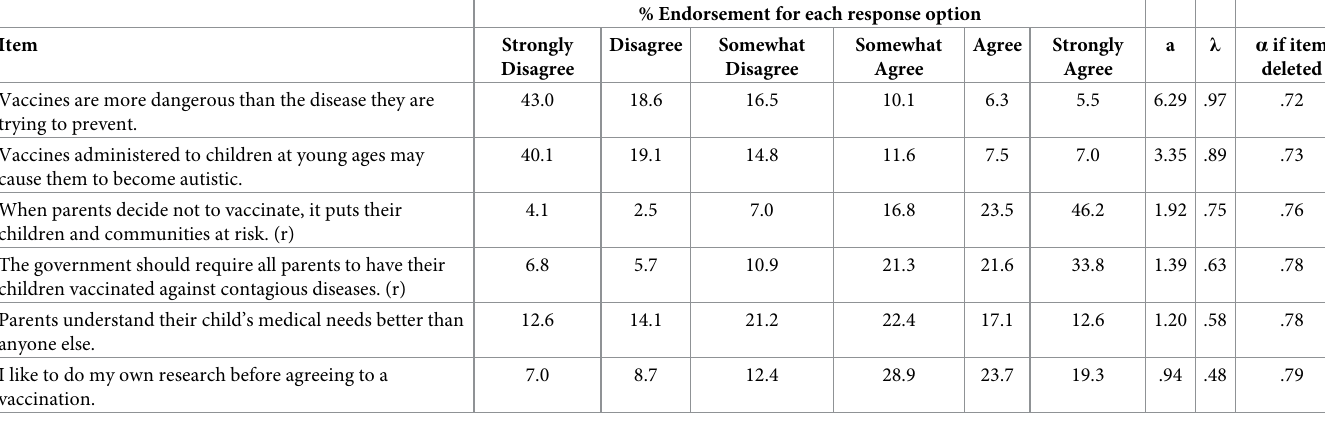
Table 2. Anti-vax scale items and psychometric